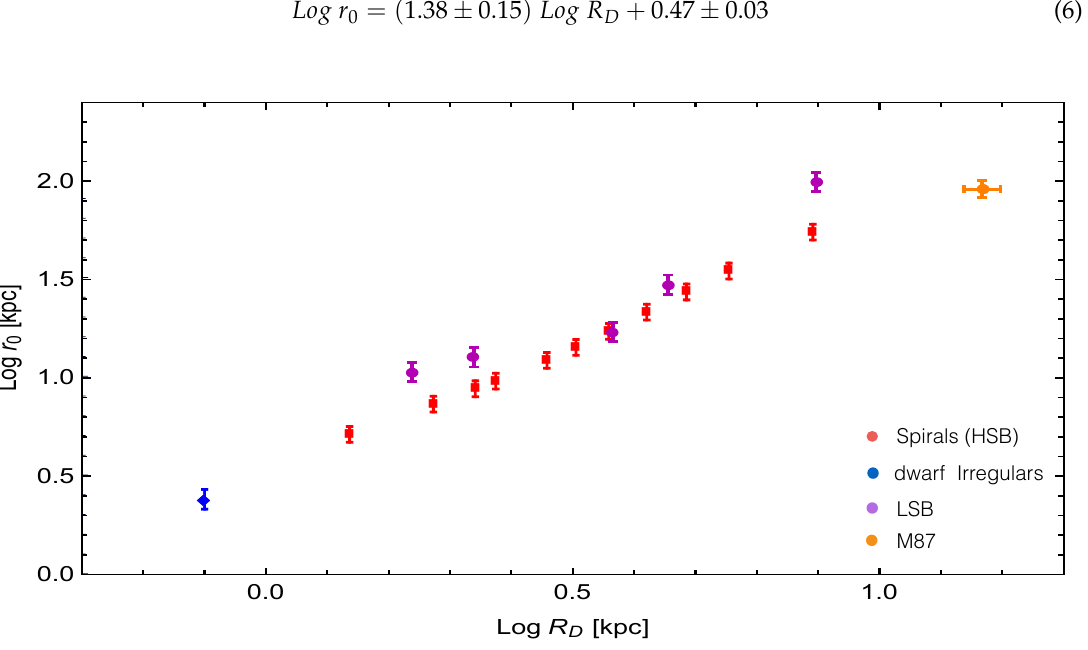
0 . 04 dex while log r D 0 . 02 dex (not  